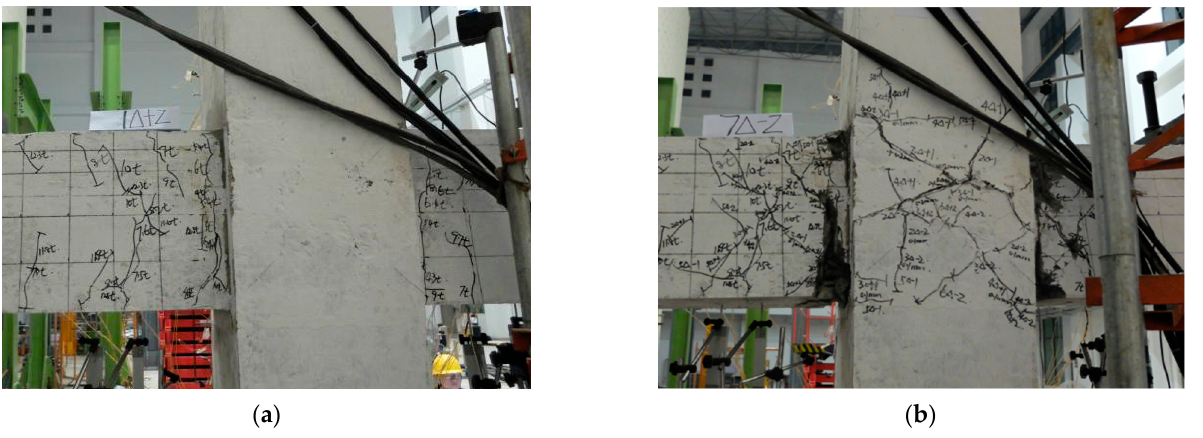
Figure 8. Crack pattern and failure mode of the PC connection: ( a ) crack at the beam end; ( b ) failure mode of the PC connection.